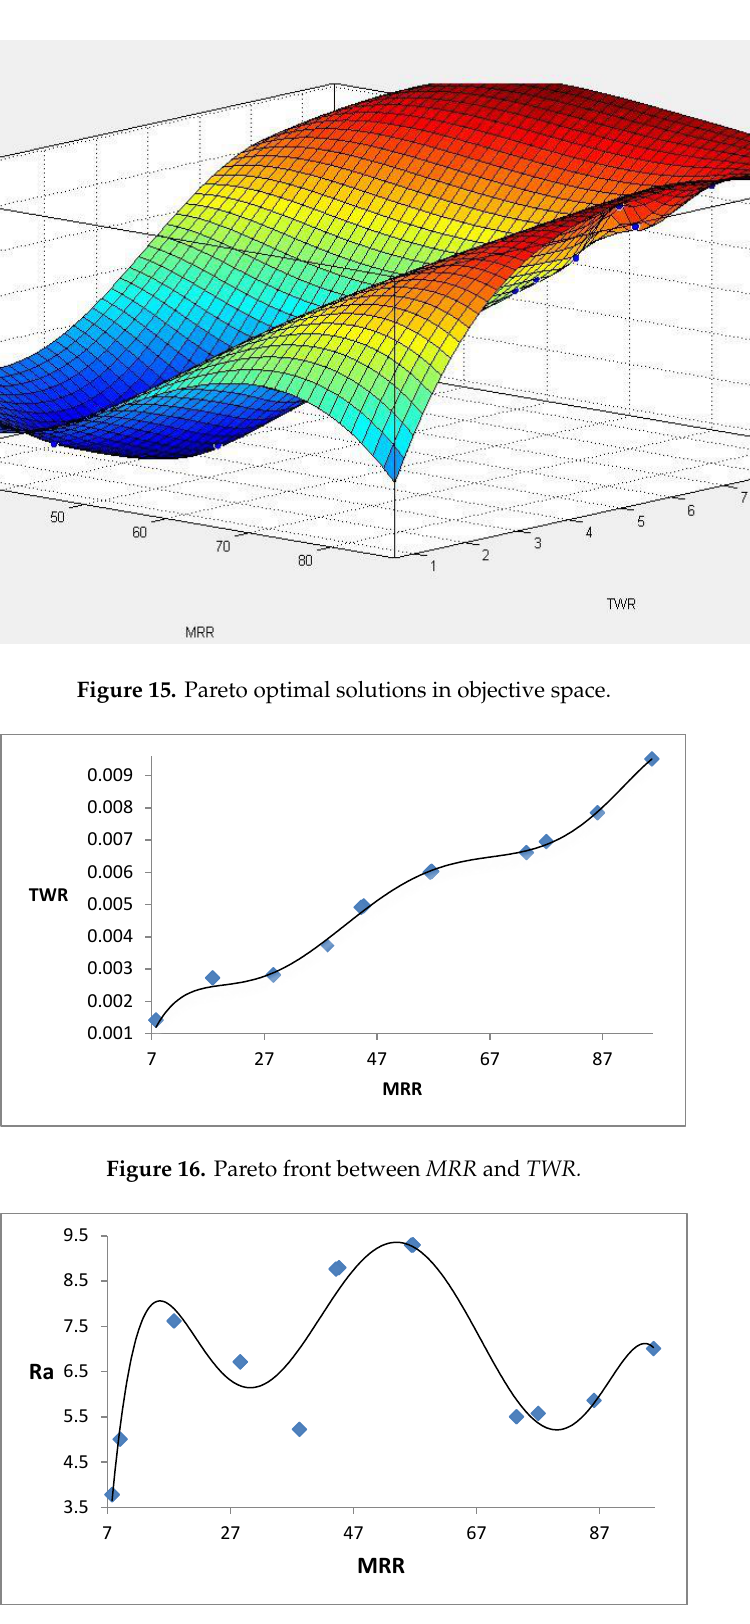
Figure 14. Optimal design variables in search space.